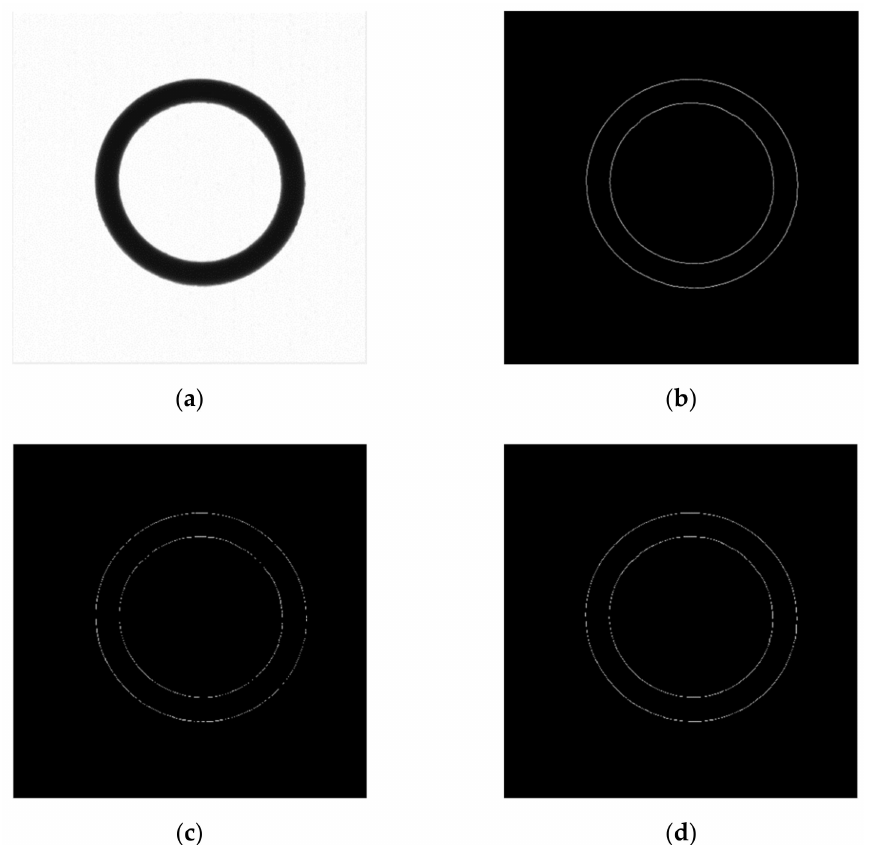
Figure 3. Comparison of noise-resistant mathematical morphological edge detection algorithm and whole-pixel edge detection algorithm. ( a ) Original image; ( b ) noise-resistant mathematical morphology edge detection results; ( c ) the Sobel operator edge detection result; ( d ) plot of the edge detection results of the Canny